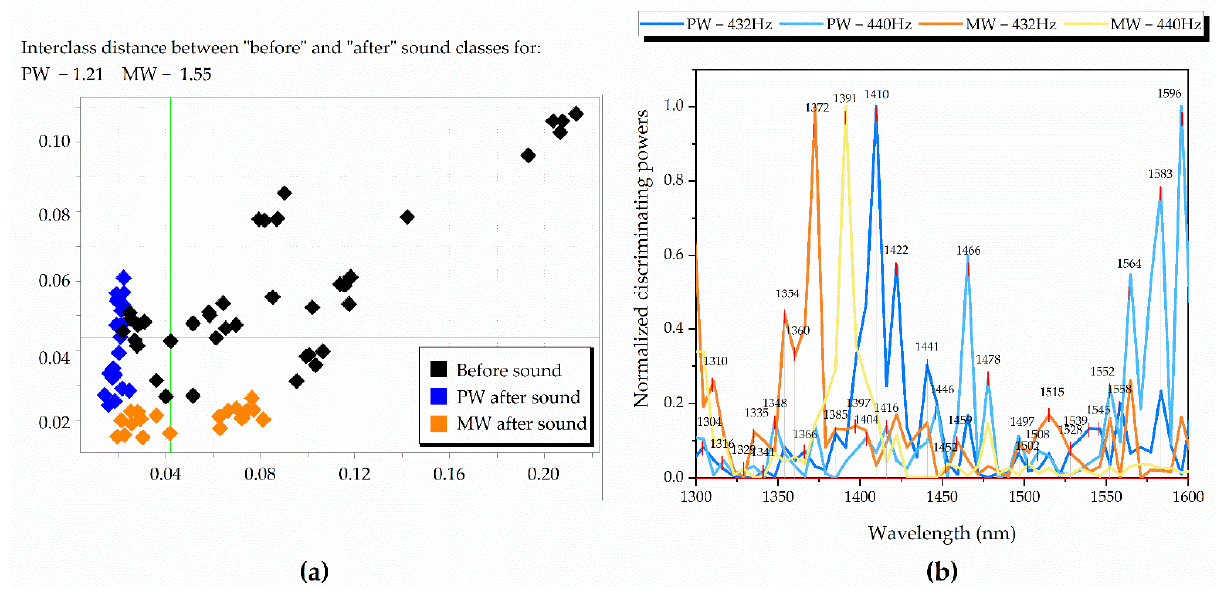
Figure 4. SIMCA classification of waters before and after sound perturbation: ( a ) Cooman’s plot with class distances between PW before sound, PW after sound, MW before sound and MW after sound; ( b ) discriminating powers comparison with applied feature scaling (normalized values from 0 to 1) between PW at 432 Hz, PW at 440 Hz, MW at 432 Hz and MW at 440 Hz, displaying prominent bands for distinguishing the sound states.